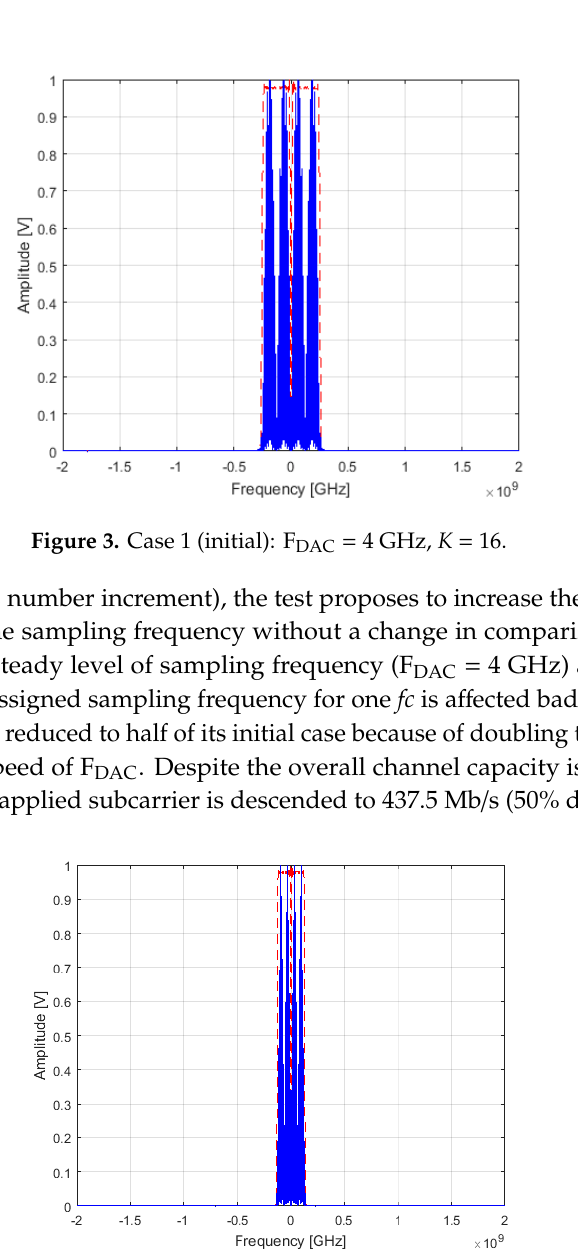
Figure 4. Case 2: F DAC = 4 GHz, K = 32.